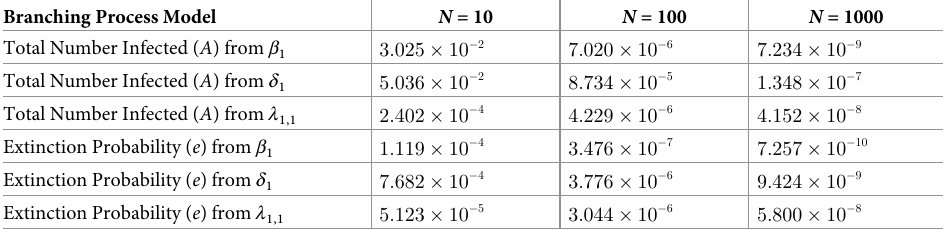
Table 10. Prediction error results for the branching process model. Derivatives are calculated with the complex per- turbation method. Parameters are generated randomly on the range β in [0.05,0.16], λ in [0.0003,0.00046], and δ = β +.03 for calculation of a sub-critical system (A) and δ = β − .03 for calculation of a super-critical system